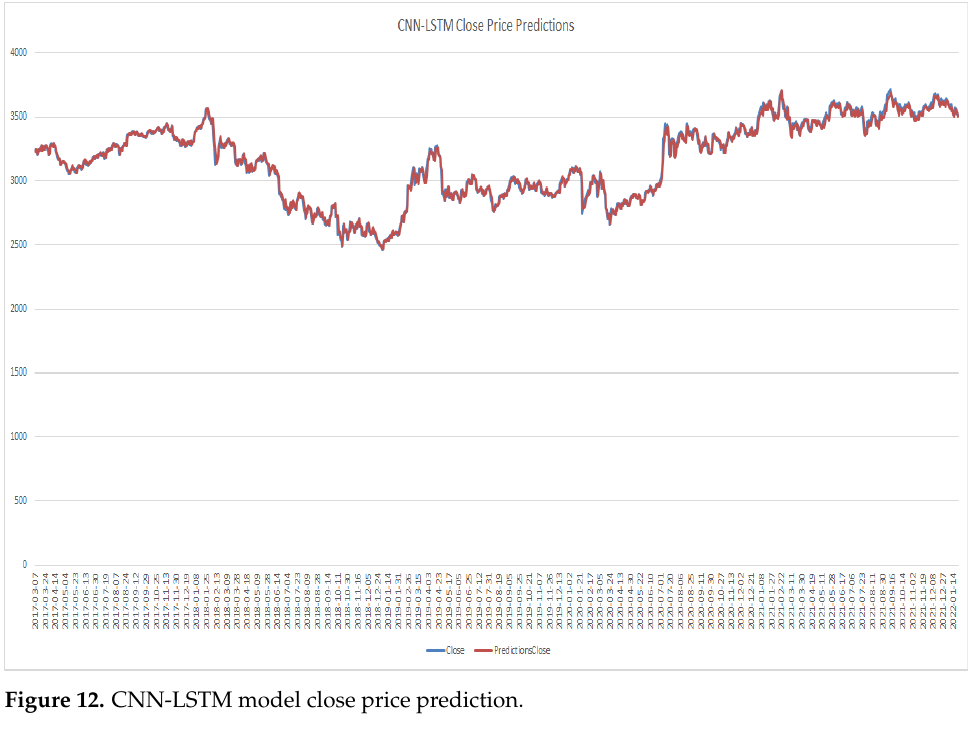
Figure 12. CNN-LSTM model close price prediction.